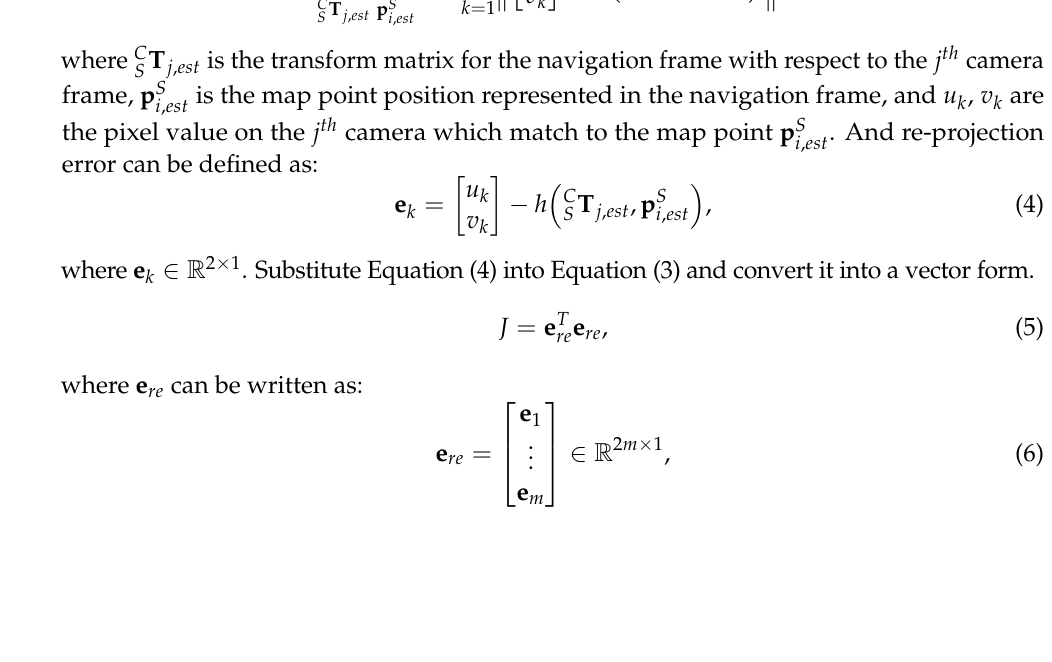
Figure 8. The result of feature matching pairs in the EuRoC dataset. (The left and right image represent the images from the left and right camera of the stereo camera, respectively.)